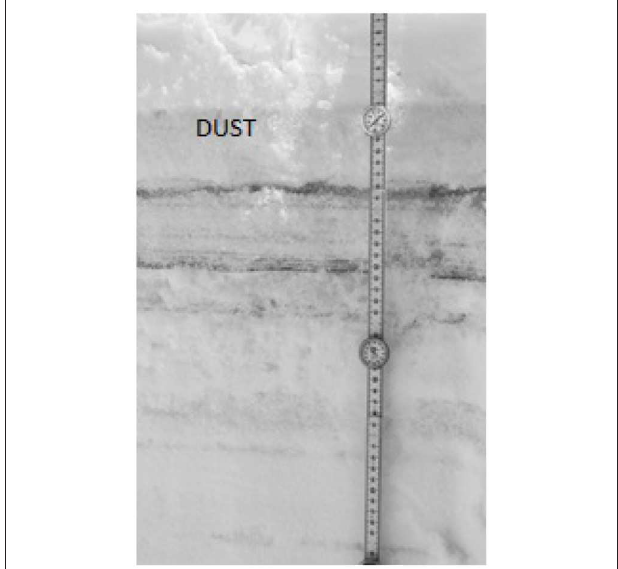
FIGURE 3 | Near infrared image of the snow pit sampled on May 1, 2017 at Swamp Angel Study Plot highlight the merged (ALM) layer at 11cm depth, denoted by “dust” label.